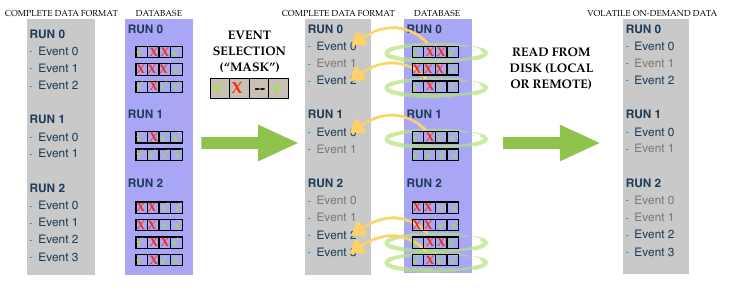
Figure 3. Access to data using the preselection